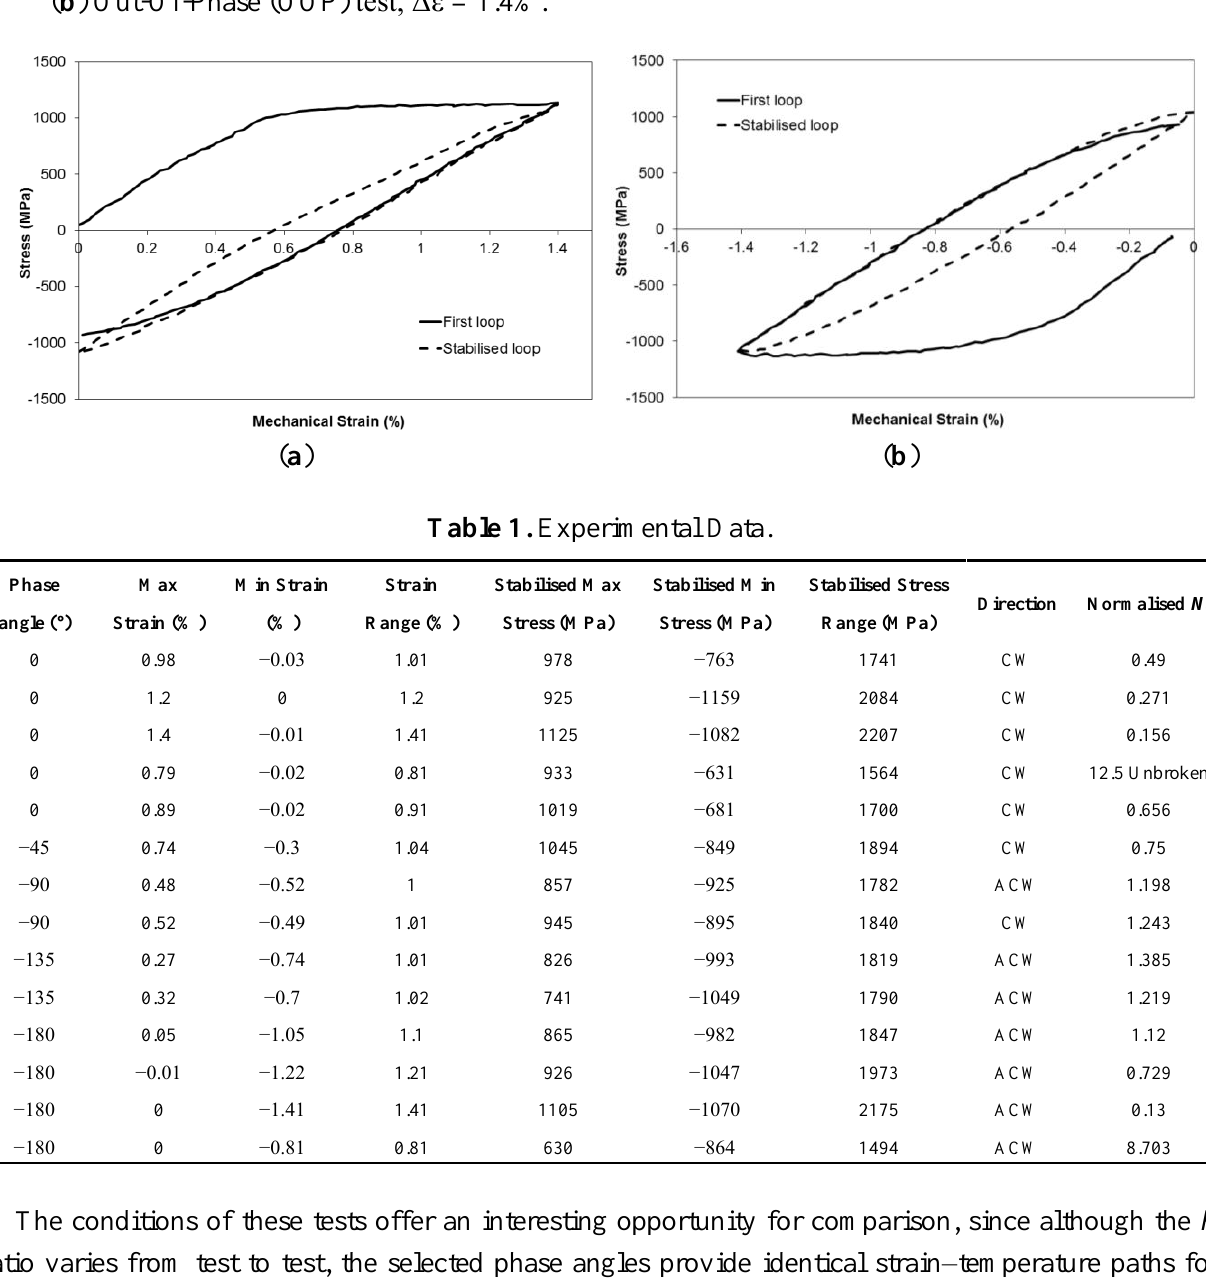
Figure 4. 1st and stabilised stress–strain hysteresis loops for ( a ) In-Phase (IP) test, Δε = 1.4%; ( b ) Out-Of-Phase (OOP) test, Δε = 1.4%.